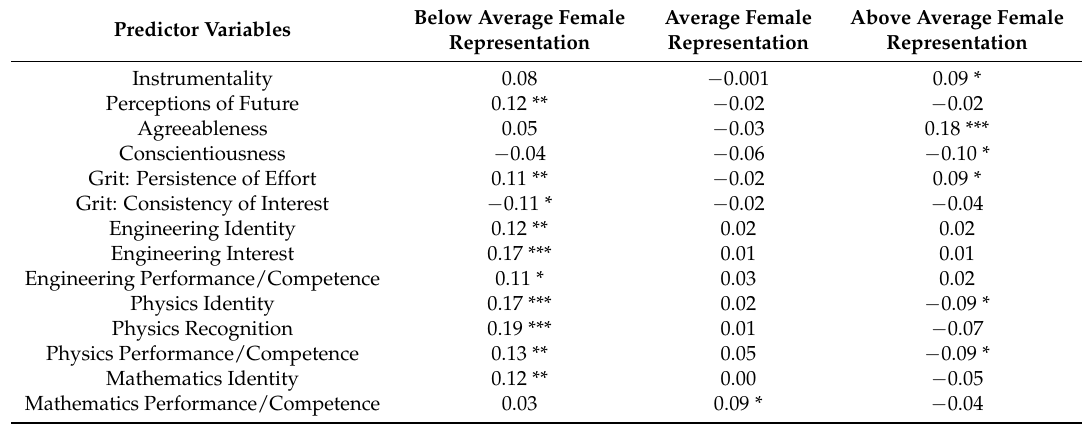
Table 3. Standardized Estimates of Multiple Regression Analysis for Factors for Attitudinal Outcomes. Predictor Variables